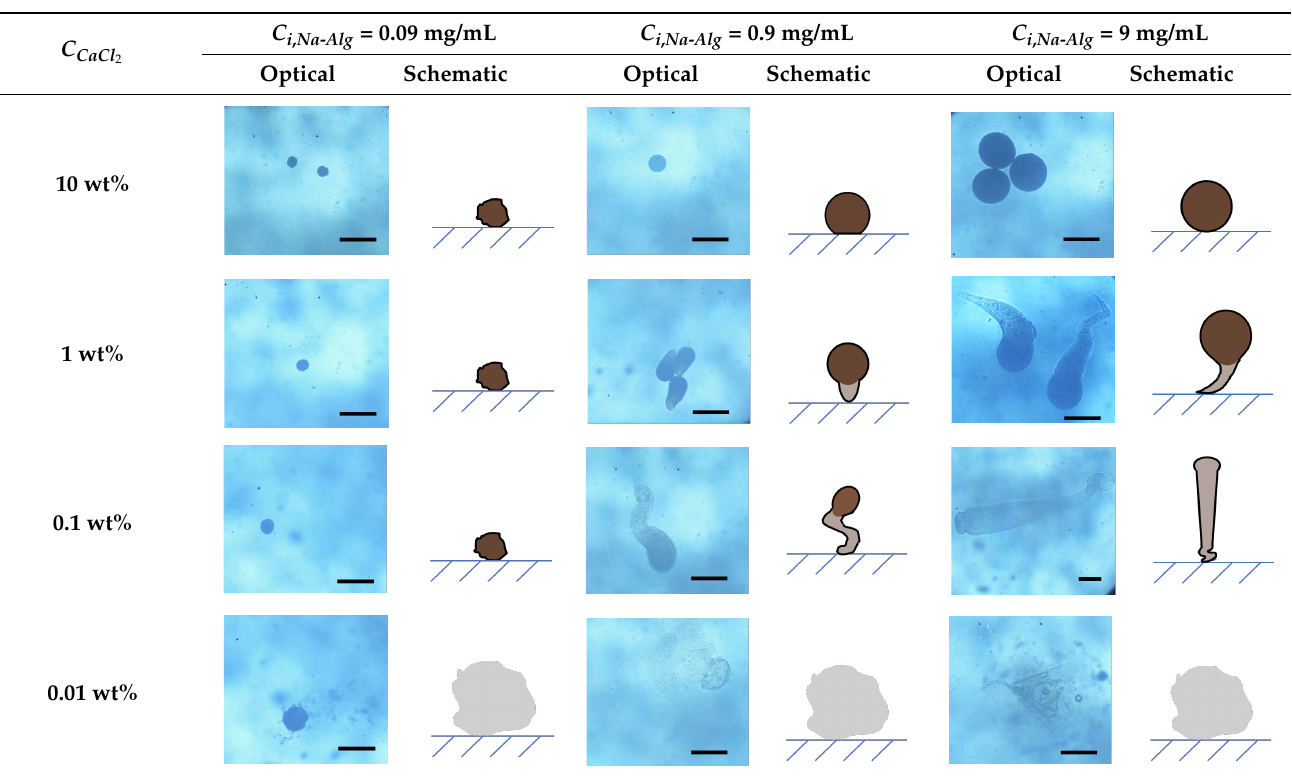
= 9 mg/mL 𝑪𝑪 𝒊𝒊 , 𝑵𝑵𝑵𝑵−𝑨𝑨𝑨𝑨𝑨𝑨